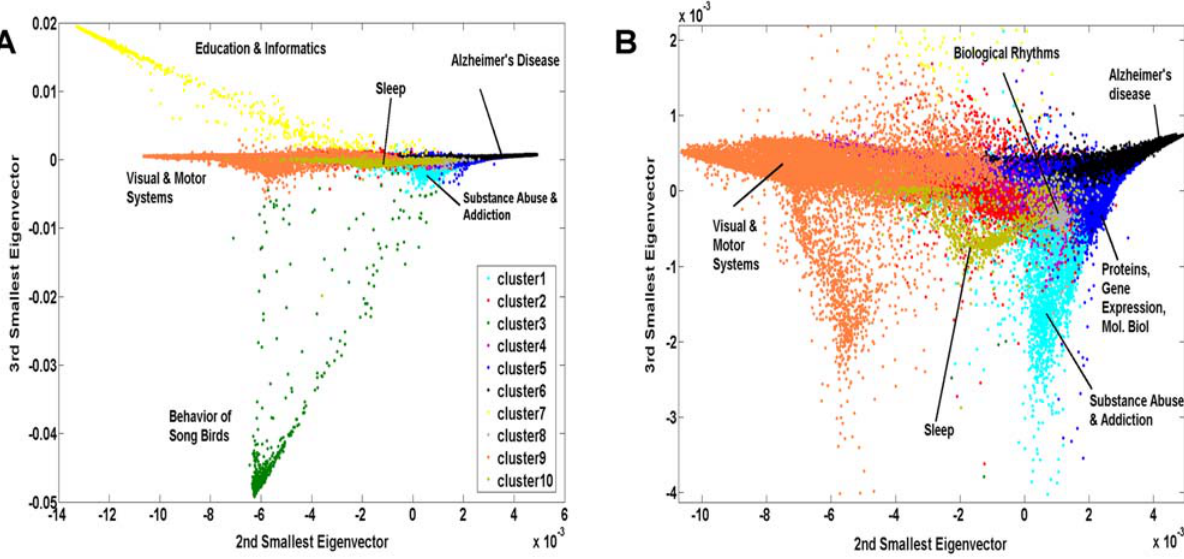
Figure 8. (A) Visualization of topic map for all SFN meeting abstracts from 2001 to 2006. Abstracts assigned to different clusters appear in different colors (see legend). (B) Zooming in at the center of the topic map reveals more detailed clusters